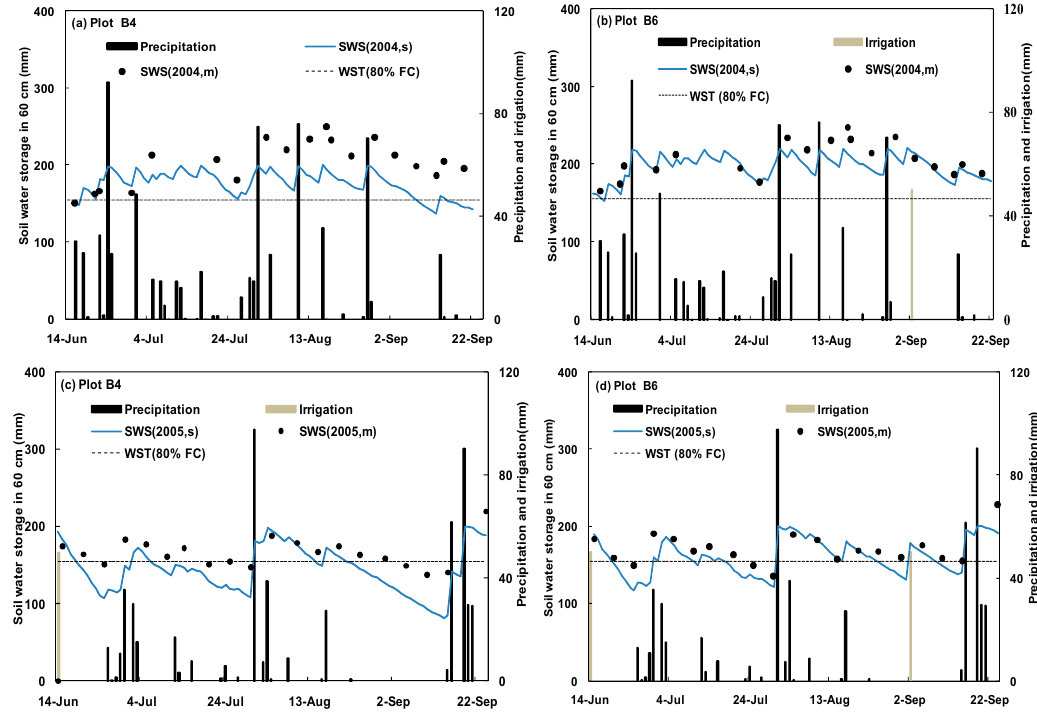
Figure 4. Comparison of simulated and measured soil water storage in the upper 60 cm during the summer maize season in 2004 and 2005. ( a ) Plot B4 in 2004; ( b ) Plot B6 in 2004; ( c ) Plot B4 in 2005; and ( d ) Plot B6 in 2005. SWS: soil water storage; s: simulated value, m: measured value; and WST: water stress threshold. Table 6. LAI parameters of summer maize.